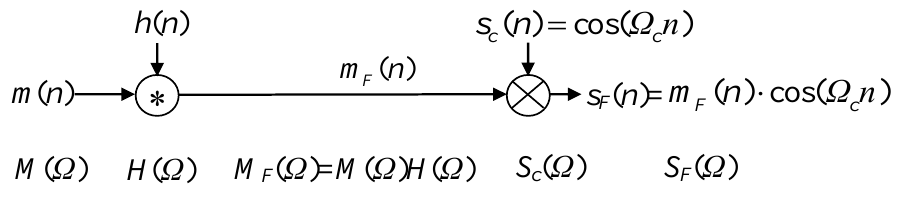
Figure 14 − Discrete-filtered pulse modulator Рис. 14 – Импульсный модулятор с дискретной фильтрацией Слика 14 – Модулатор дискретног и филтрираног